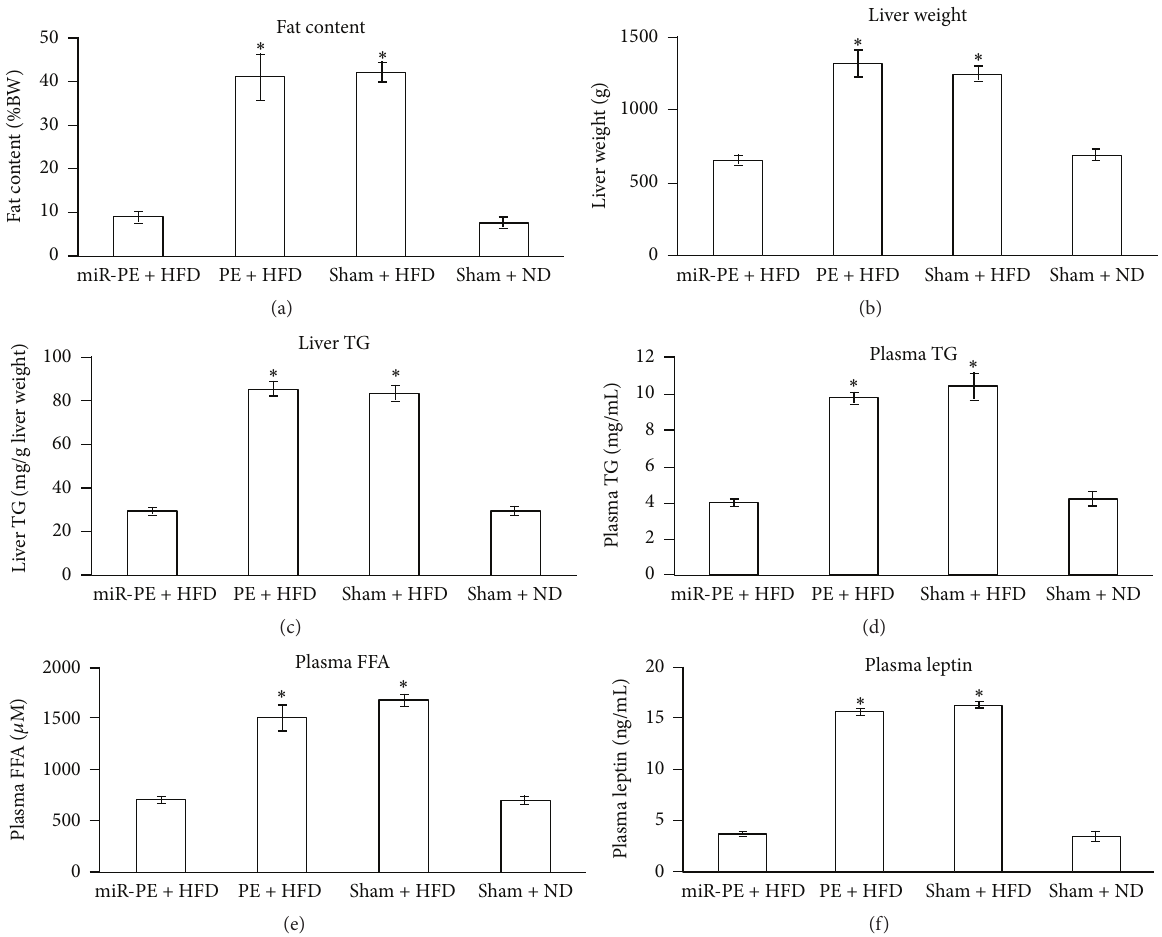
Figure 5: Fat content, liver weight and TG level, and plasma TG, FFA, and leptin level. (a) Fat content of animals at week 16. (b) Liver weight of animals at week 16. (c) Liver TG level of animals at week 16. (d) Plasma TG level of animals at week 16. (e) Plasma FFA level of animals at week 16. (f) Plasma leptin level of animals at week 16. All values are given as mean; error bar represents standard error. ∗ 𝑝 < 0.05 , compared with Sham + ND